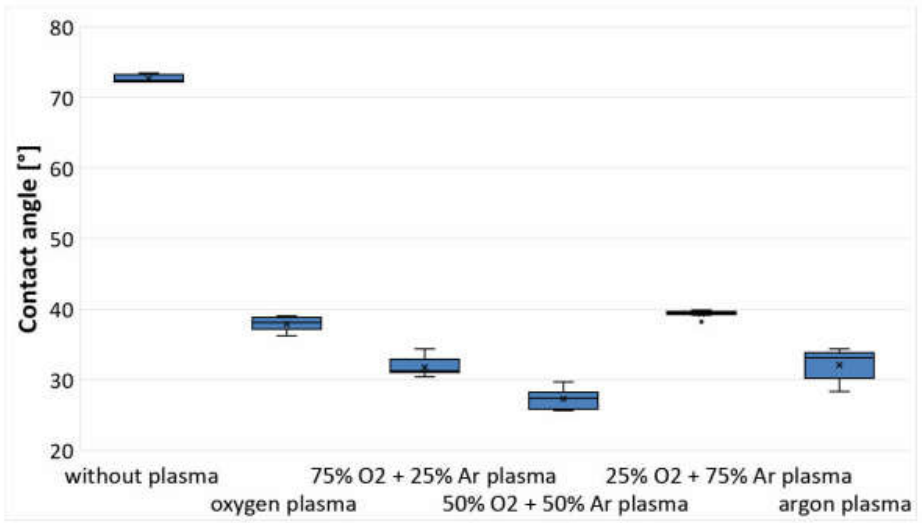
Figure 1. Values of water contact angle of PLA film, unmodified and plasma modified, using different gas compositions (box plot chart for 15 measurements, where: upper whisker—maximum, lower whisker—minimum, box height shows 1st and 3rd quartile and includes median).